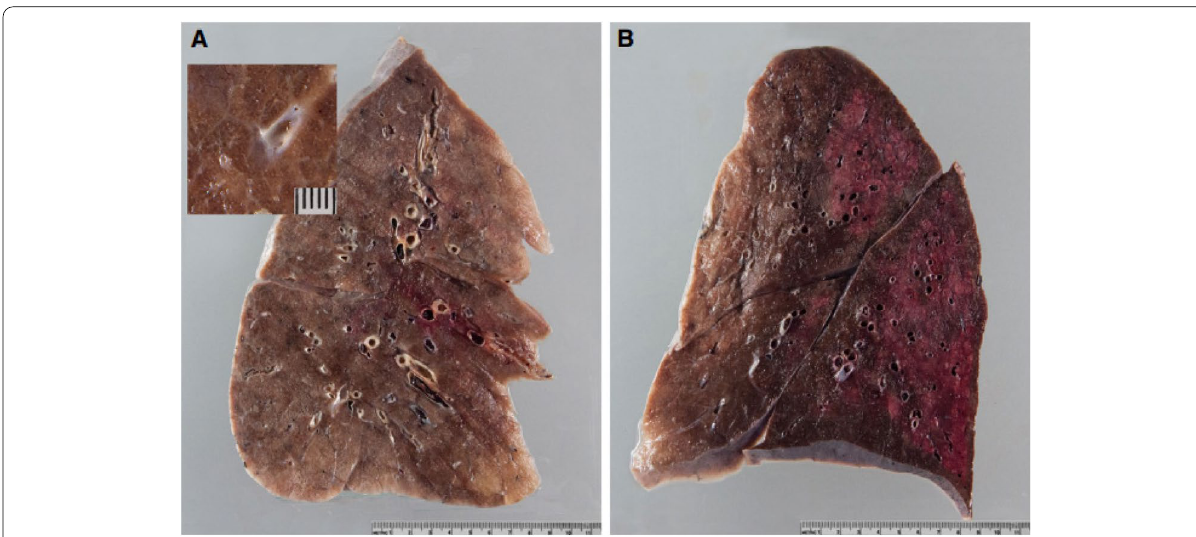
Fig. 2 Gross lung findings. A Typical appearance of coronavirus disease 2019 (COVID-19) lungs; note the perceptibly thickened alveolar septae and congestive interstitial aspects and a thrombembolus in the lower lobe. Insert: detailed view highlighting interstitial congestion. B Extensive bronchopneumonic infiltrates in a COVID-19 patient suffering from superimposed suppurative pneumonia. Note: Source of figure from Menter et al. (2020) (Menter et al.